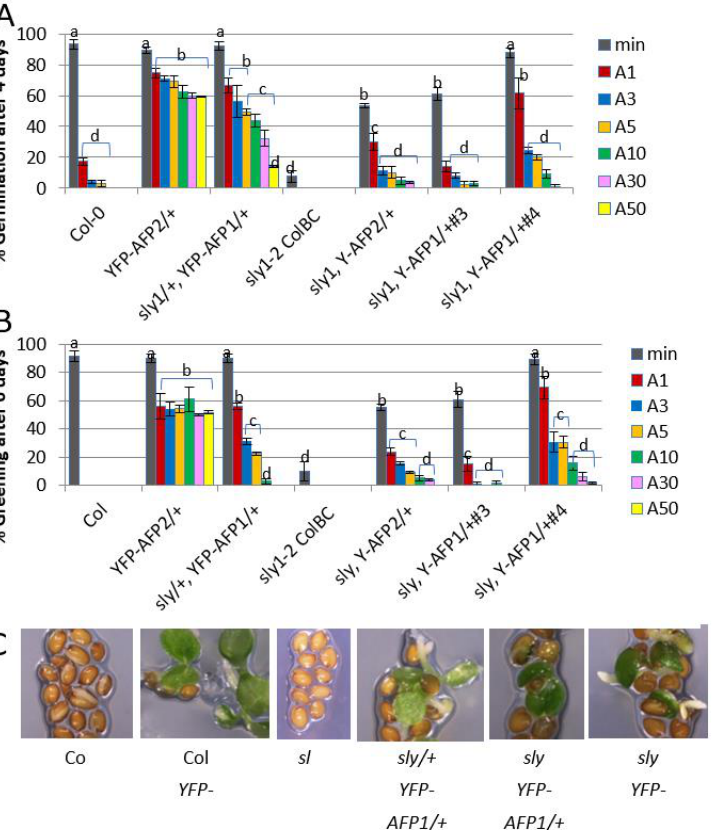
Figure 2. Effects of overexpressing YFP-AFP fusions in wild-type (Col-0) vs. sly1 mutants on ABA sensitivity of seeds. ( A ) Germination of the indicated genotypes after 4 days on media with no ABA (min) or 1–50 µ M ABA (A1–A50). ( B ) Greening of the germinated seedlings after 6 days on the media described in ( A ). Data displayed is the average of at least triplicate assays for each genotype and treatment + S.E. Bars with different letters represent statistically different values using Tukey’s HSD post hoc test ( p < 0.01). ( C ) Representative images of seeds/seedlings after 6 days on 5 µ M ABA.